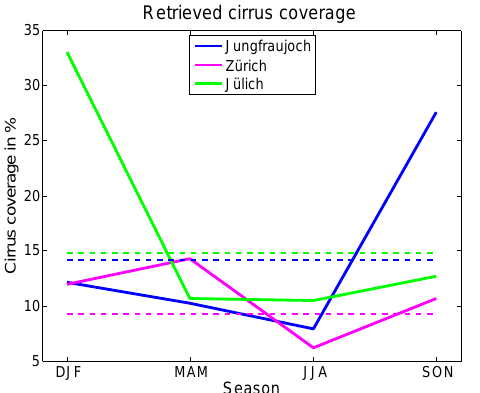
Figure 3. Seasonal cycle of cirrus cloud coverage for the three mea- surement sites. Dashed lines: annual means.